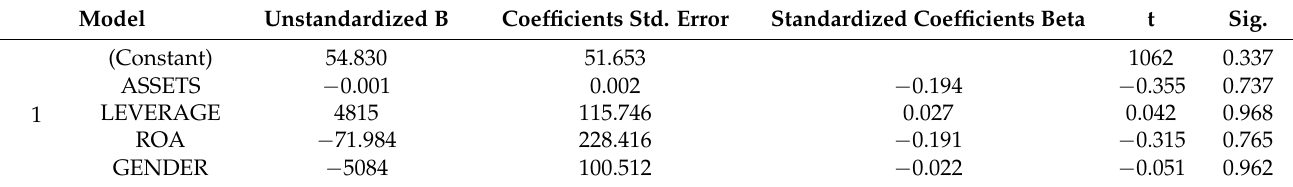
Table 7. Regression Results for RD as the Dependent